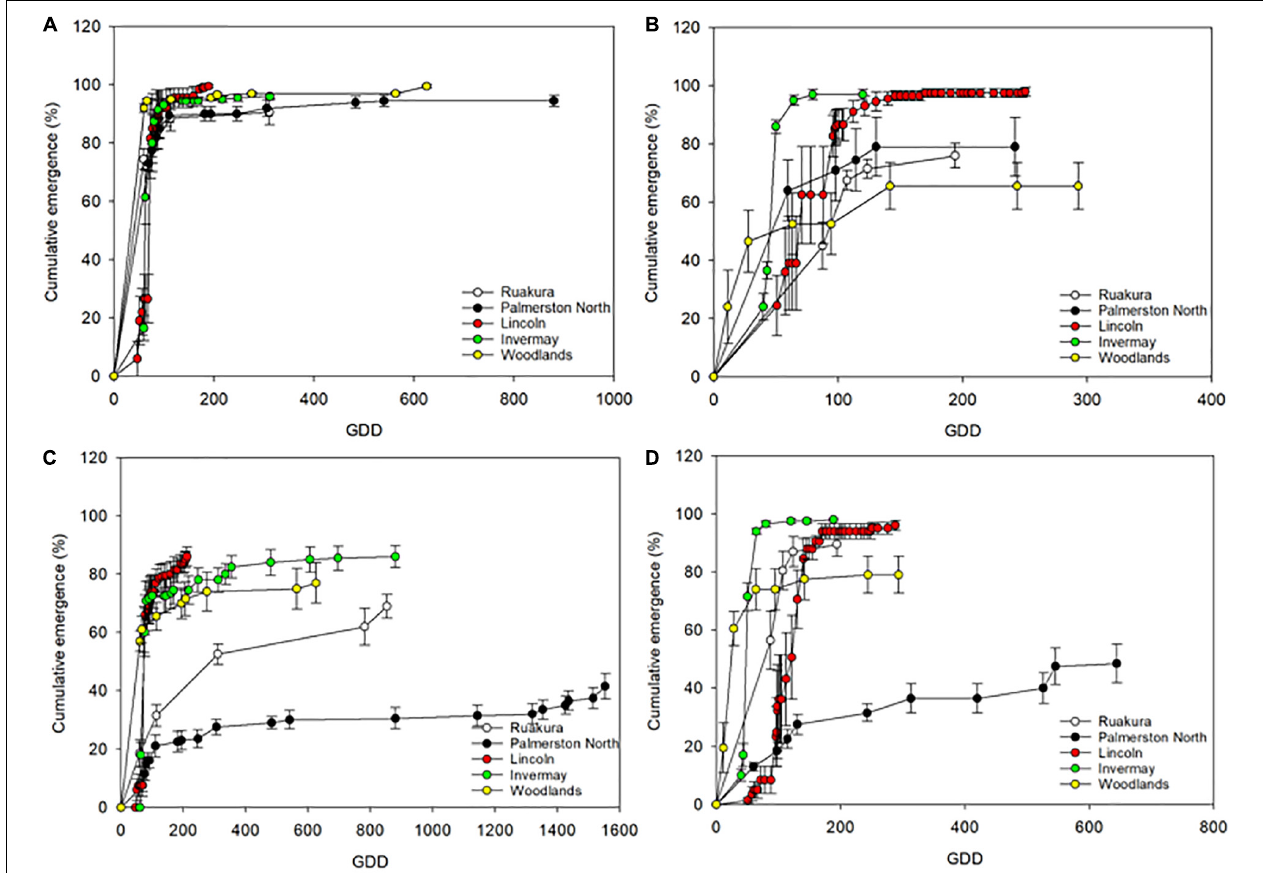
FIGURE 1 | Cumulative seeding emergence of casual (A,B) and naturalized (C,D) populations of A. theophrasti in the first (A,C) and second (B,D) experiments as related to cumulative growing-degree days (GDD). The experiments were conducted in five different regions of New Zealand. The error bars represent ± standard error of the